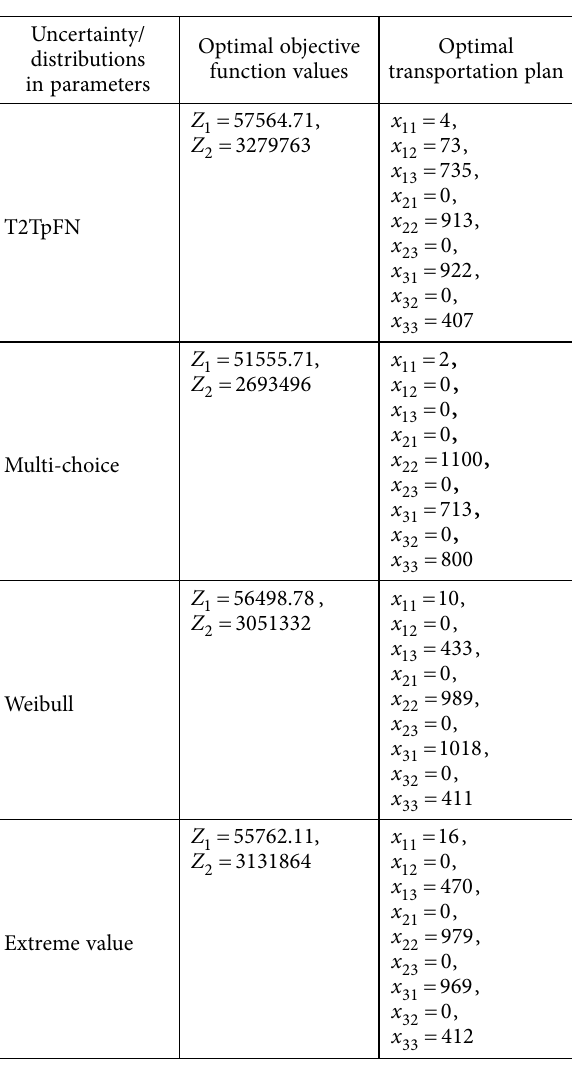
Table 15. Analysis of compromise solutions Uncertainty/ Optimal objective distributions function values in parameters